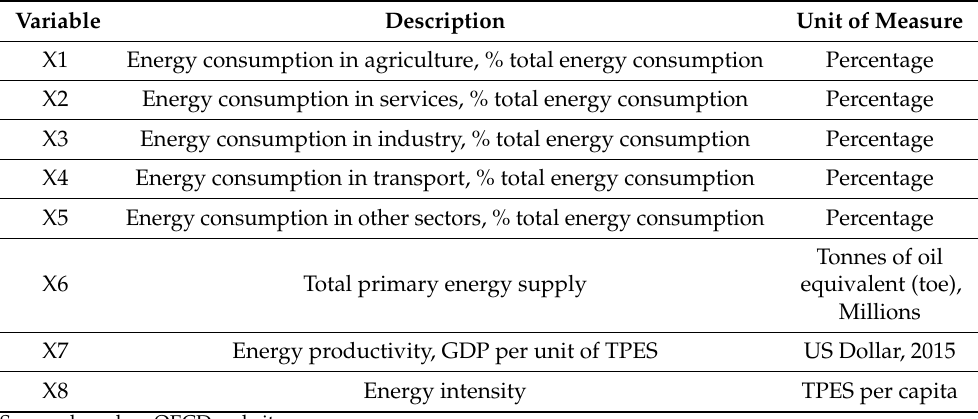
Table 1. List of variables used in the